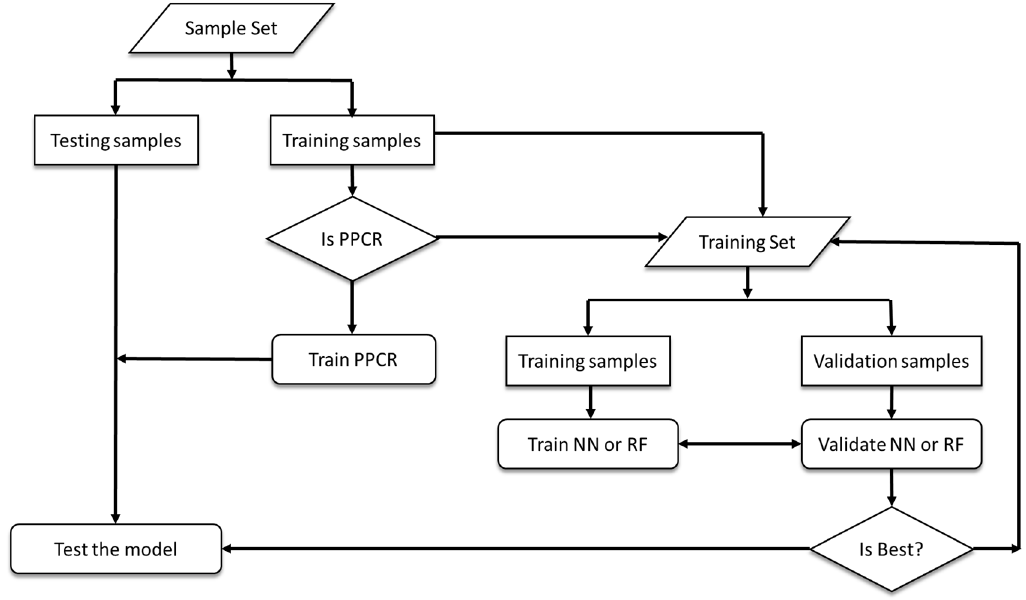
Figure 2. Flowchart showing the development of the strawberry yield model employing PPCR, NN, and RF.